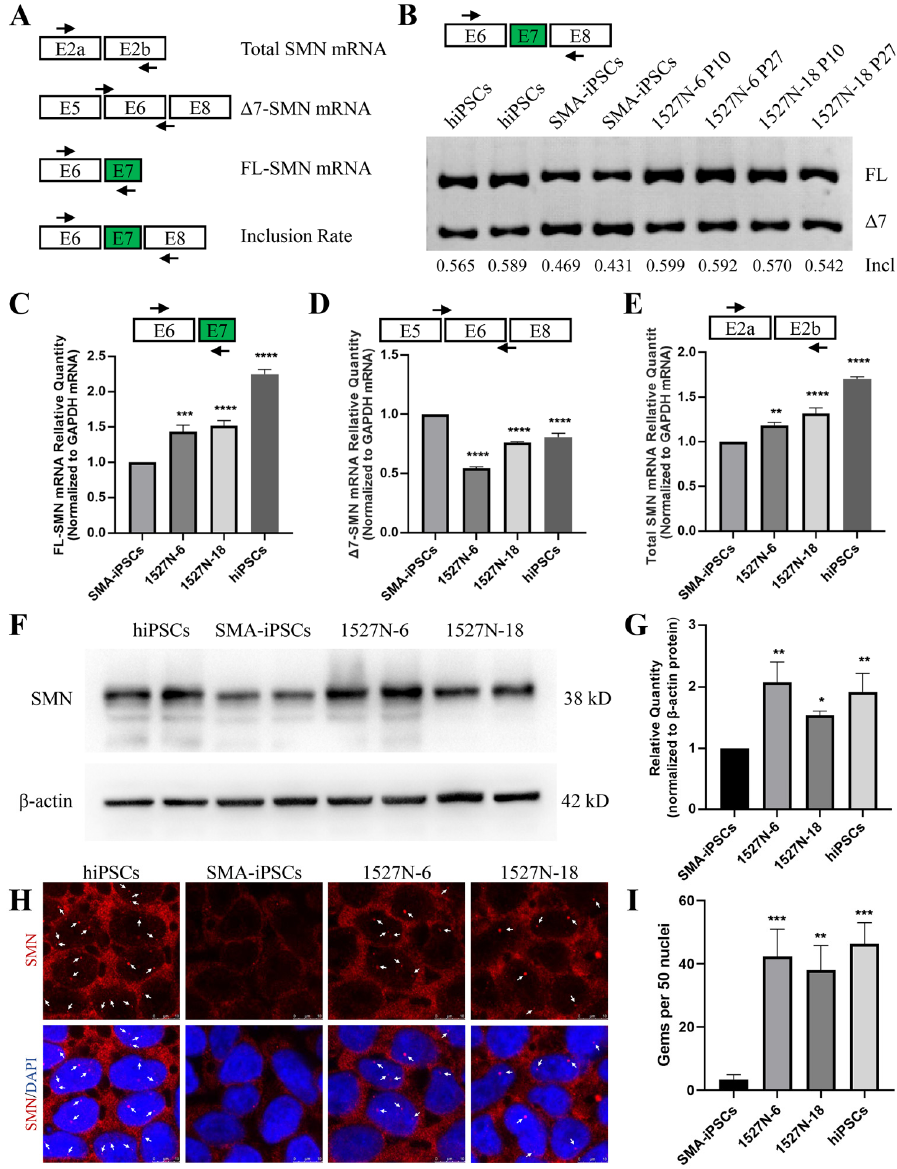
Figure 3. Restored SMN expression in iPSCs. ( A ) Schematic representation of the locus of the four primer pairs. E, exon. ( B ) RT-PCR analysis of SMN2 mRNA in hiPSCs, SMA-iPSCs, and targeted-deletion iPSCs. The targeted-deletion iPSCs were evaluated in passages (P) 10 and 27. Incl = FL/(FL + ∆ 7). ( C – E ) qRT-PCR analyzed the expression of FL-SMN, ∆ 7-SMN, and total SMN mRNA. GAPDH was used as the internal reference. Bars represent the Mean ± standard error of the mean (SEM); n = 3. ** p < 0.01. *** p < 0.001. **** p < 0.0001. ( F ) The SMN protein expression levels in hiPSCs, SMA-iPSCs, and targeted-deletion iPSCs (1527N-6 and 1527N-18). B-actin was used as the internal reference. ( G ) Values for each sample were normalized to β -actin protein levels. Data shown indicate mean ± standard deviation (SD). * p < 0.05. ** p < 0.01. ( H ) Immunofluorescence of SMN in hiPSCs, SMA-iPSCs, and targeted-deleted iPS cell lines. The red fluorescence shows SMN protein, and the gems were pointed out with white arrows. DAPI was used to visualize the nucleus. ( I ) The number of gems was more in the hiPSCs and targeted-deletion iPSCs compared with SMA-iPSCs. Data shown indicate mean ± SD. ** p < 0.01. *** p <